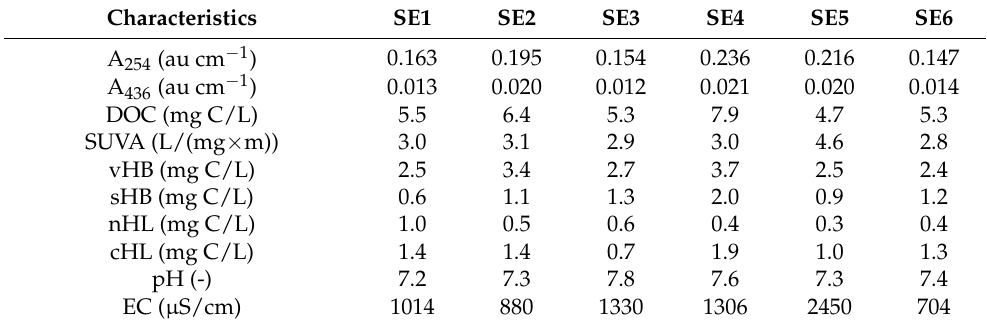
Table 3. Characteristics of the secondary effluents from two WWTPs (prior to PhC spiking).